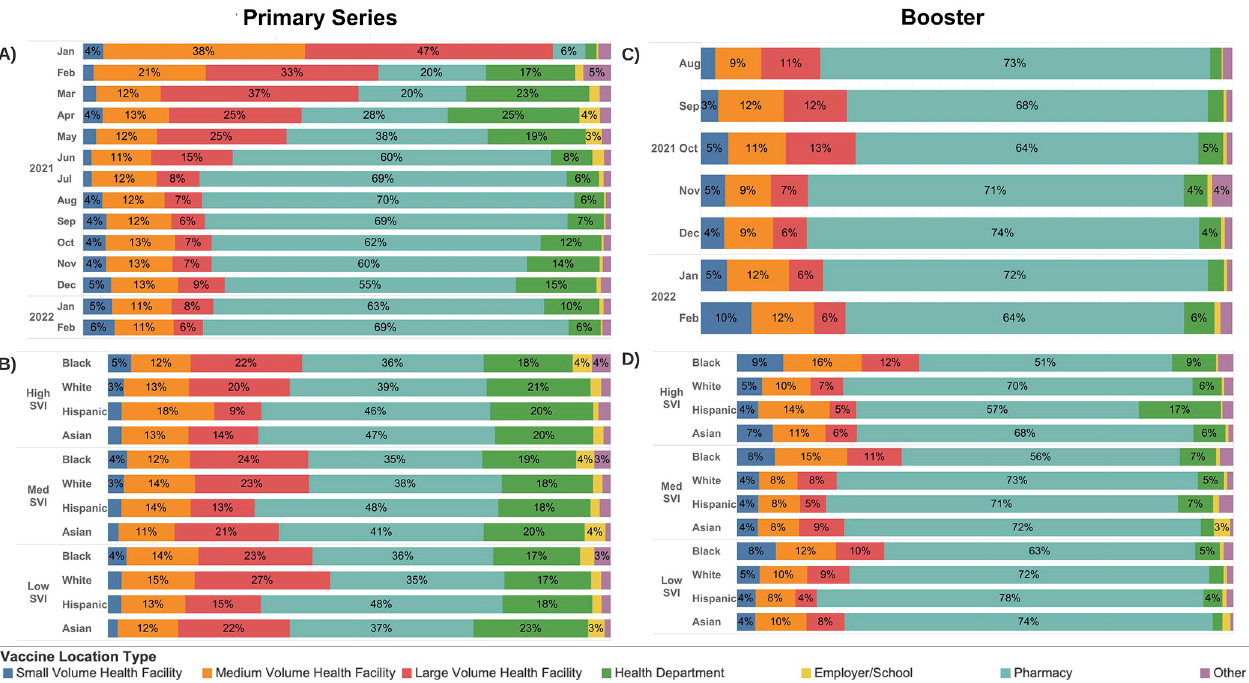
PLOS Medicine| https://doi.org/10.1371/journal.pmed.1004048 August 26,